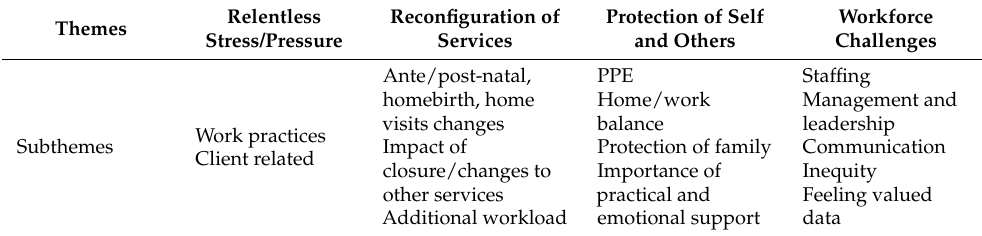
Table 2. Qualitative analysis; theme and